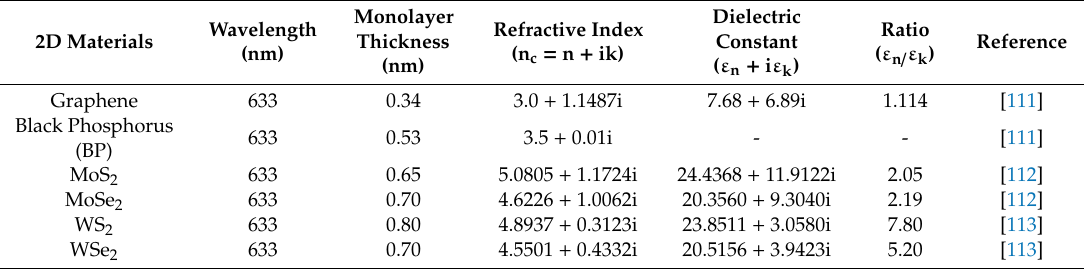
Table 5. Values of the refractive index and dielectric constants for the di ff erent 2D